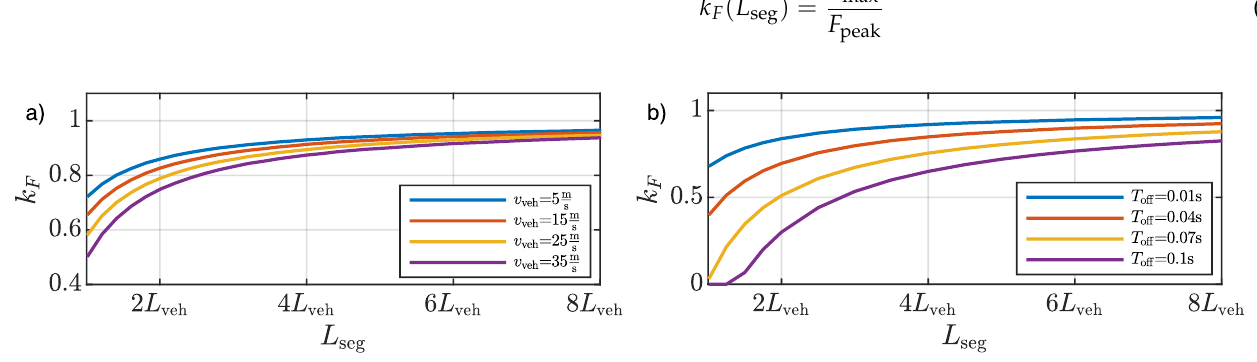
Figure 5. Characteristics of k F in relation to L seg for various ( a ) v veh and ( b ) T off .